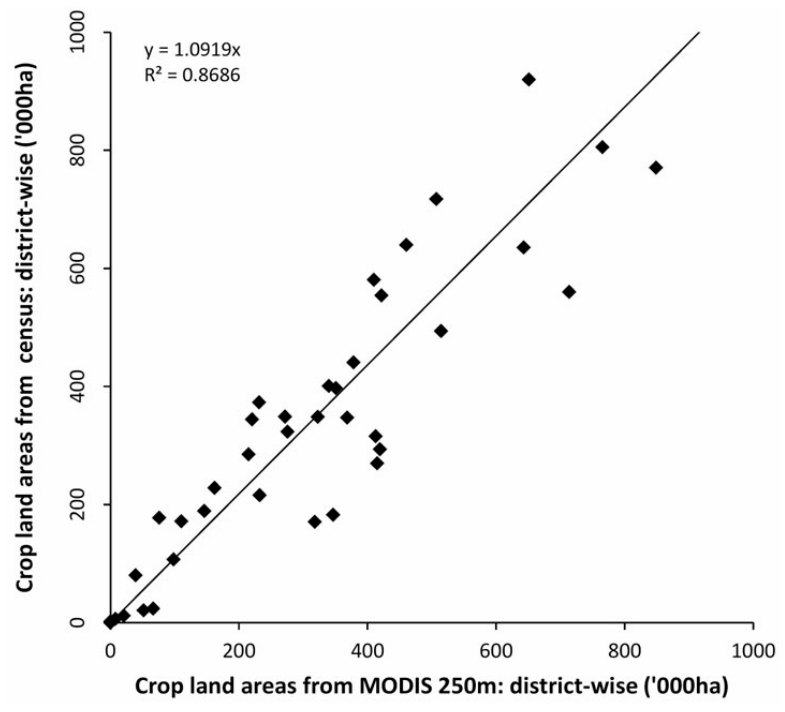
Figure 8. A comparison of district-wise cropland area from the MODIS classification and national statistics.